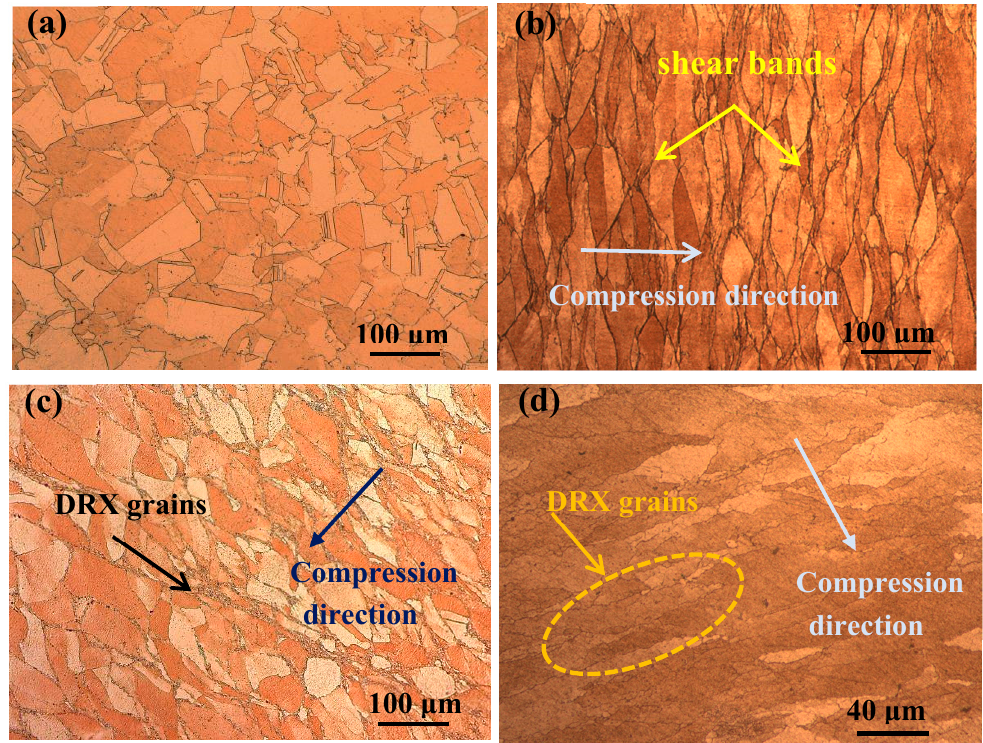
Figure 2. Optical images of the Cu-Ni-Co-Si-Cr-Ce alloy microstructure deformed under different conditions: ( a ) solid-solution; ( b ) 500 °C and 0.01 s − 1 ; ( c ) 700 °C and 0.01 s − 1 ; and ( d ) 900 °C and 0.01 s − 1 .